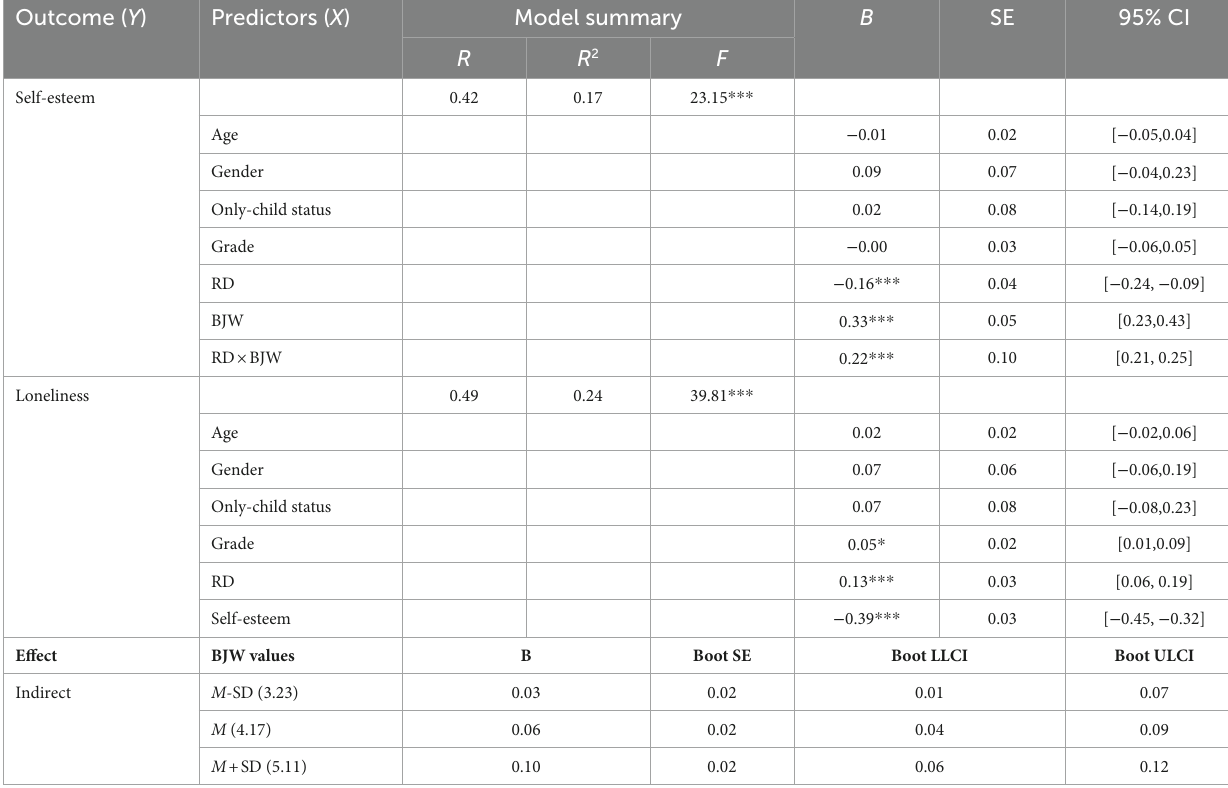
TABLE 8 Robustness test: moderated mediation analysis results with BJW as a moderator. Outcome ( Y